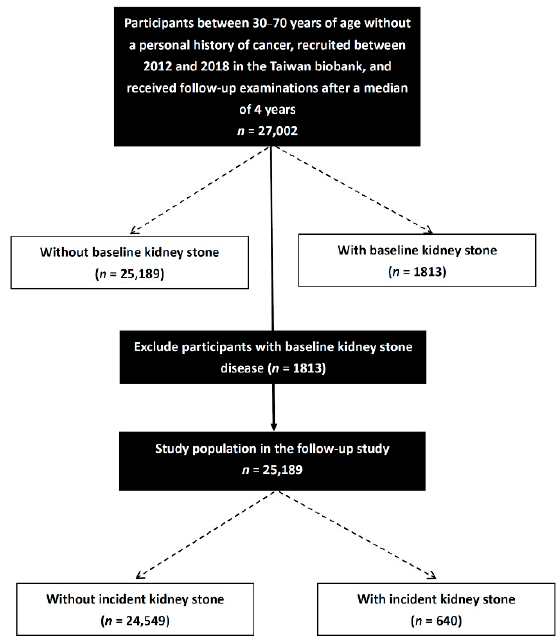
Figure 1. Flowchart of study